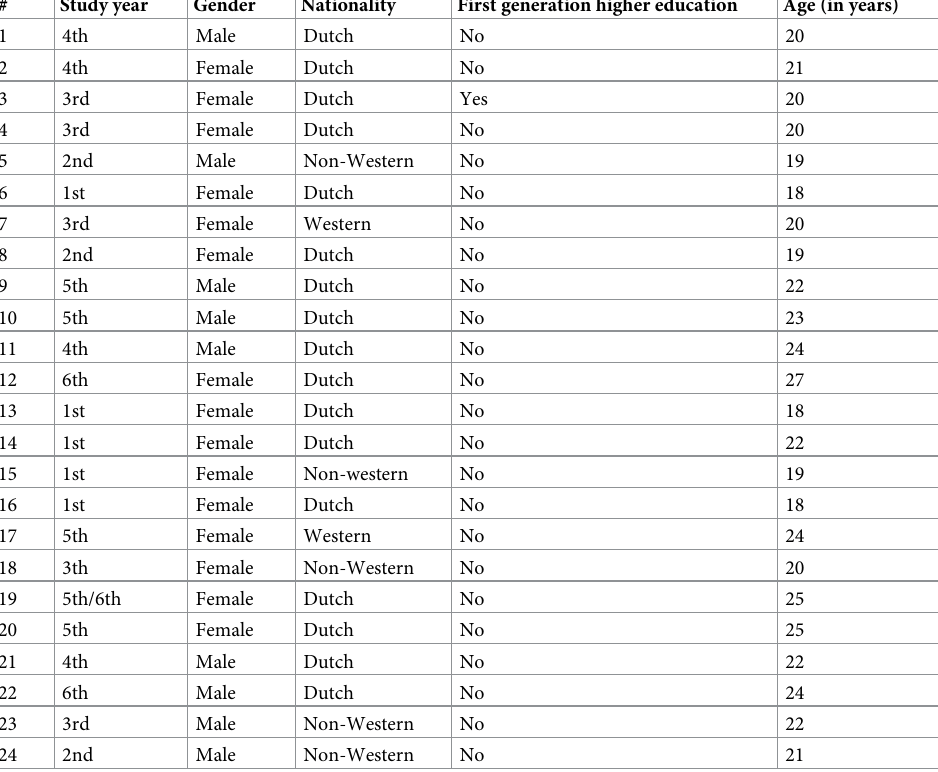
Table 1. Demographic characteristics